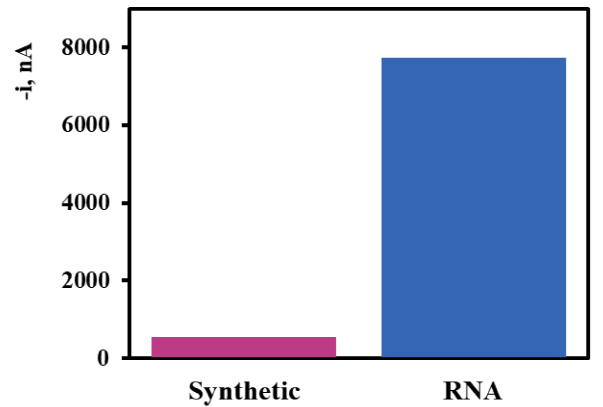
Figure 2. Comparison of the 20-fold di ff erence in signal intensity of Probe 17 between real RNA and synthetic target DNA for 100 pM